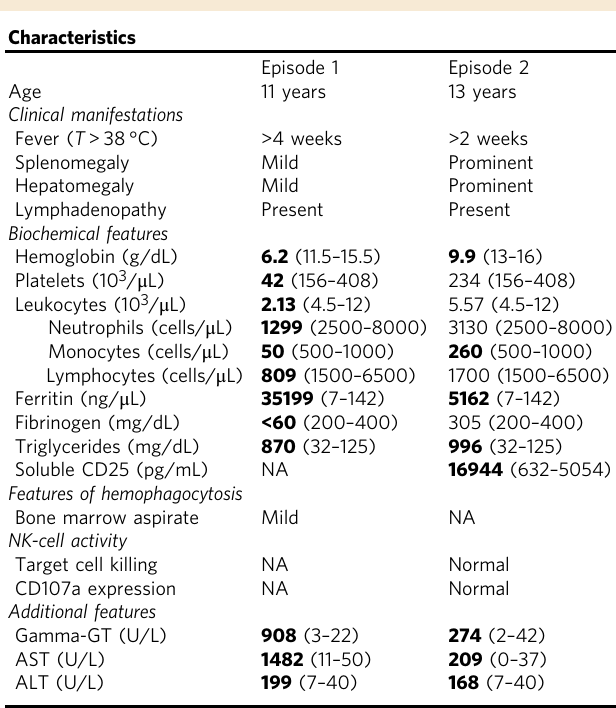
Table 1 Characteristics of relapsing hyperin fl